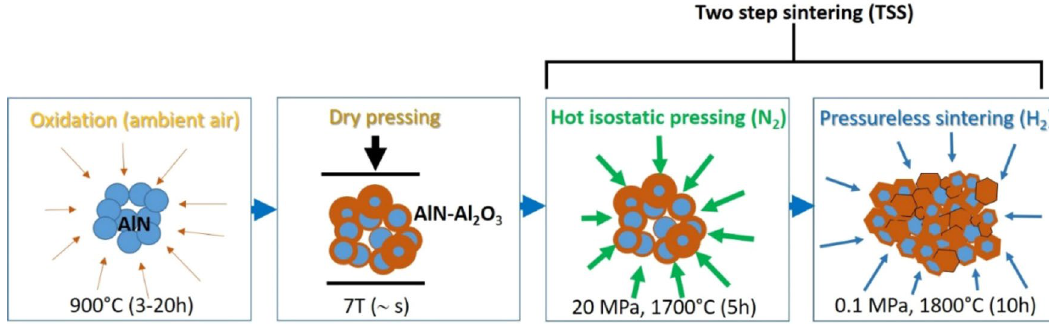
Figure 1. Experimental procedure of Al 2 O 3 sintered sample preparation from AlN